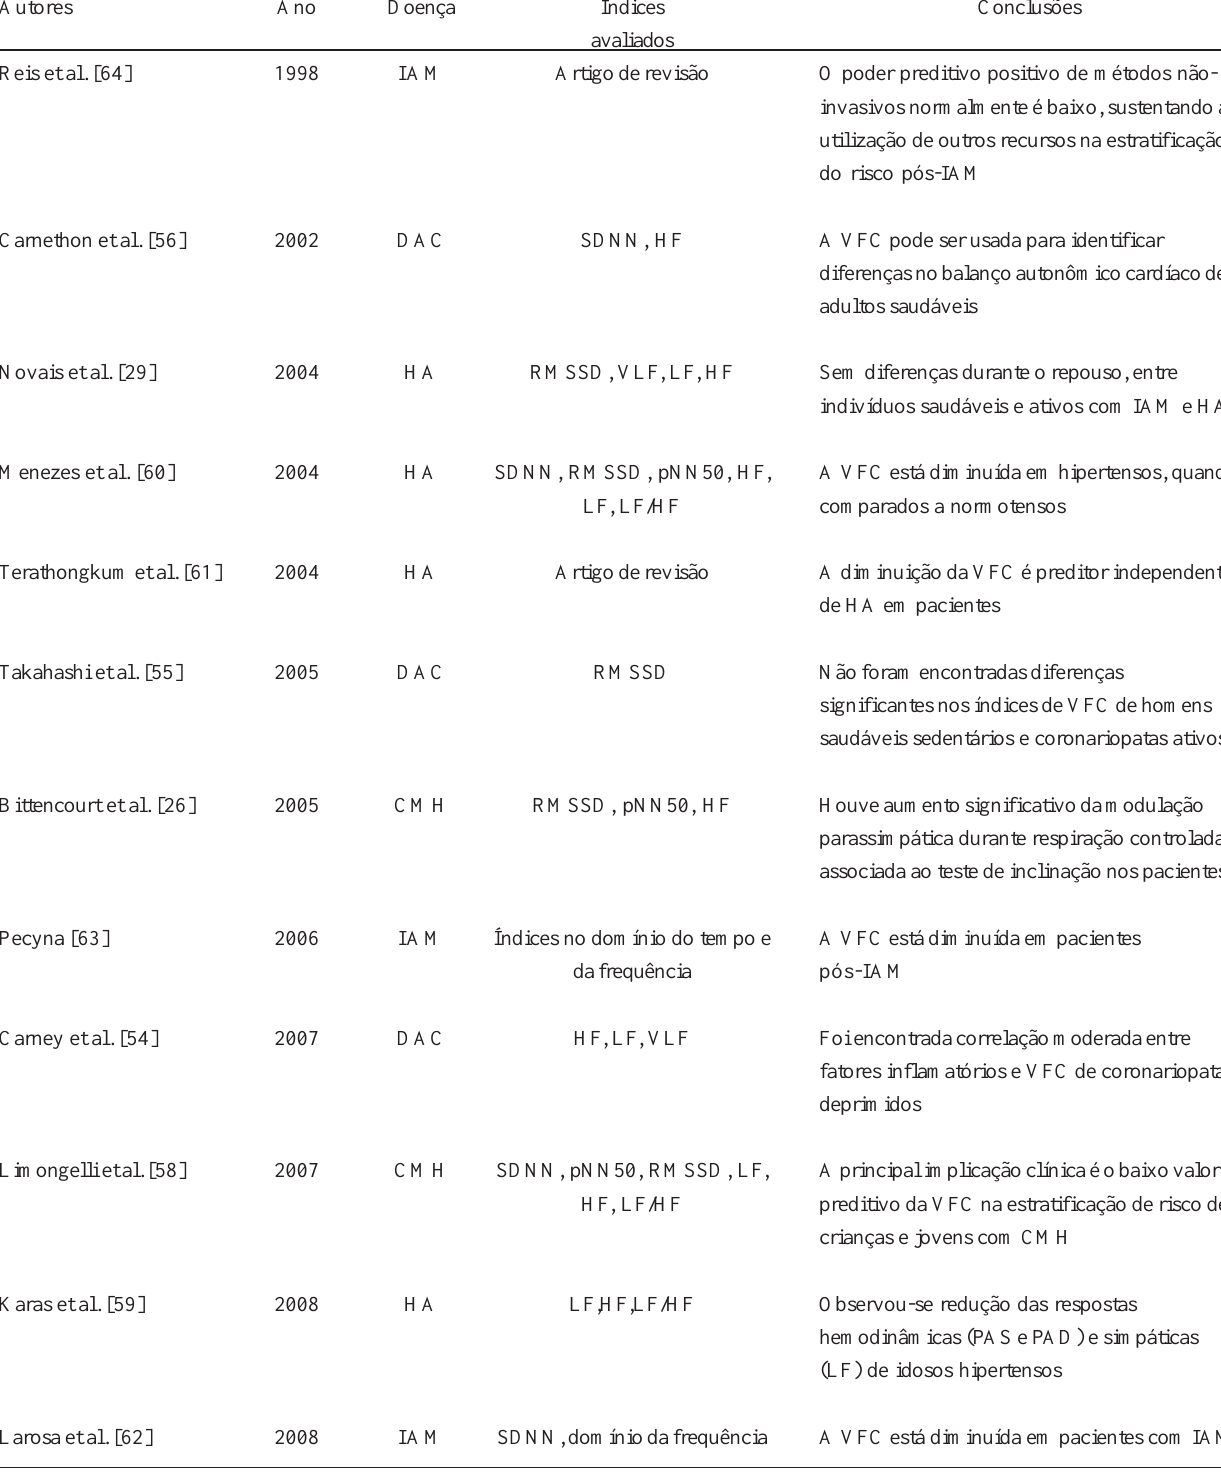
IAM: infarto agudo do miocárdio; DAC: doença arterial coronariana; HA: hipertensão arterial; CMH: cardiomiopatia hipertrófica; VFC: variabilidade da frequência cardíaca; PAS: pressão arterial sistólica; PAD: pressão arterial